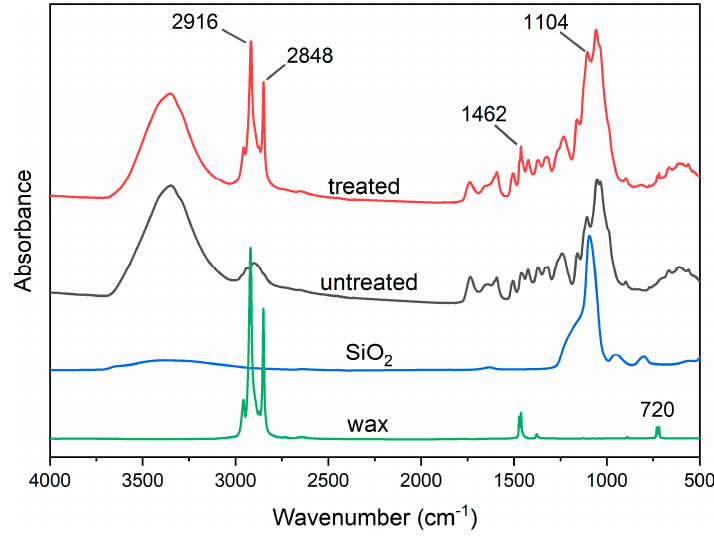
Figure 6. Fourier-transform infrared spectrophotometer (FTIR) spectra of the SiO 2 , wax, untreated, and treated wood samples. Due to the impregnation, new peaks at 2916, 2848, and 720 cm − 1 , derived from wax, appeared in the spectrum of treated wood samples and the peaks at 1462 and 1104 cm − 1 were also